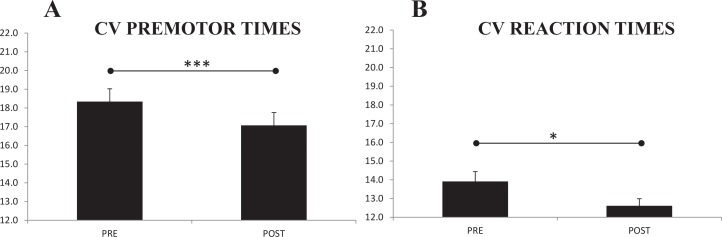
(A) The CV of PMT was reduced significantly at Post, regardless stimulation modes, tasks or muscles (so that shown pooled). (B) A similar pattern was found for the CV of RT. *p<0.05; ***p<0.001.